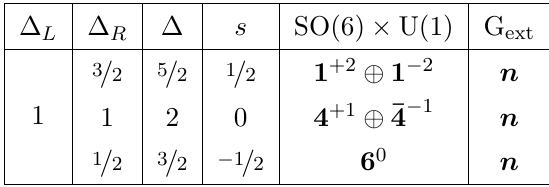
1 ; 1) solutions with chiral embedding (2.21a). The gauge j U(1) G ext (cid:2) (cid:2)